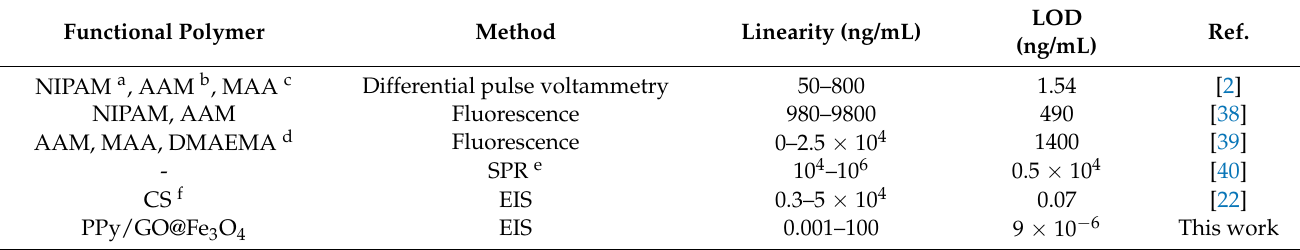
Table 1. Comparison of the analytical performance of the fabricated MIPPy/GO@Fe 3 O 4 -based microsensor with previously published sensors for LYS